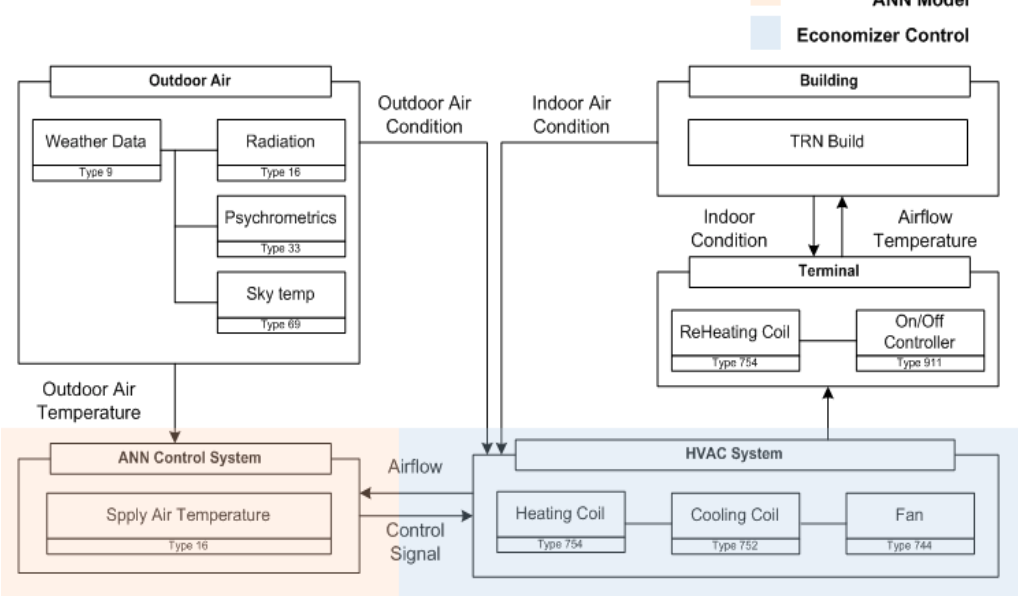
Figure 12. Analysis of room temperature according to the proposed control method.